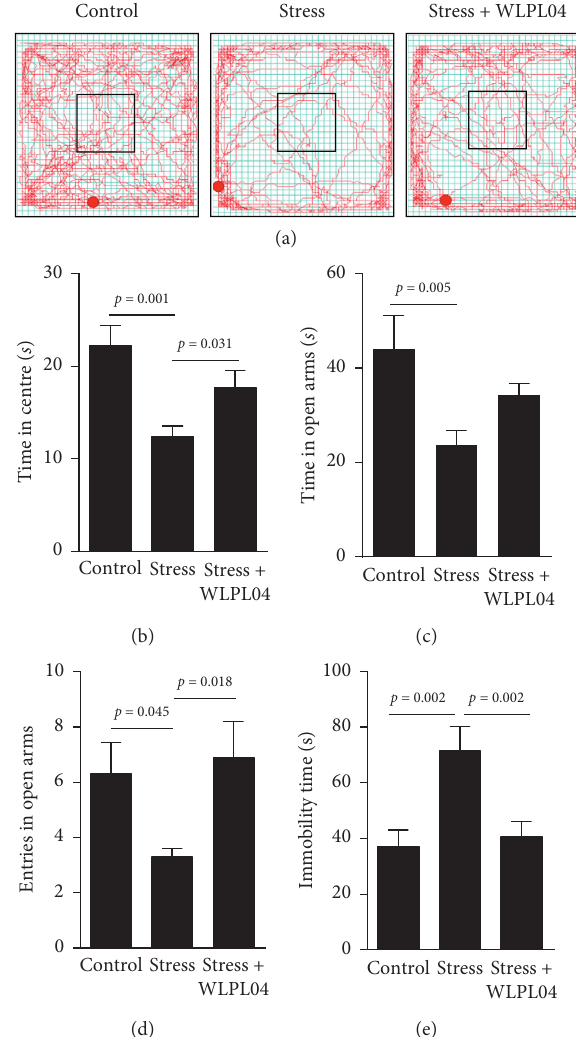
Figure 2: L . plantarum WLPL04 treatment reduces anxiety-like behaviors in chronically stressed mice. (a) The moving trajectory of the three groups of mice in the open-field test. (b) Chronically stressed mice exhibit significantly ( p < 0.01) less time in the central area of the open field, and such behavioral phenotype is alleviated by the L . plantarum WLPL04 treatment. Chronically stressed mice have spent (c) significantly ( p < 0.01) less time and (d) significantly ( p < 0.05) fewer entries into the open arms in the elevated plus maze test, and such behavioral phenotypes are alleviated by the L . plantarum WLPL04 treatment. (e) Chronically stressed mice demonstrate significantly ( p < 0.01) longer immobility time, and such behavioral phenotype is alleviated by the L. plantarum WLPL04 treatment. n � 7–12 mice per